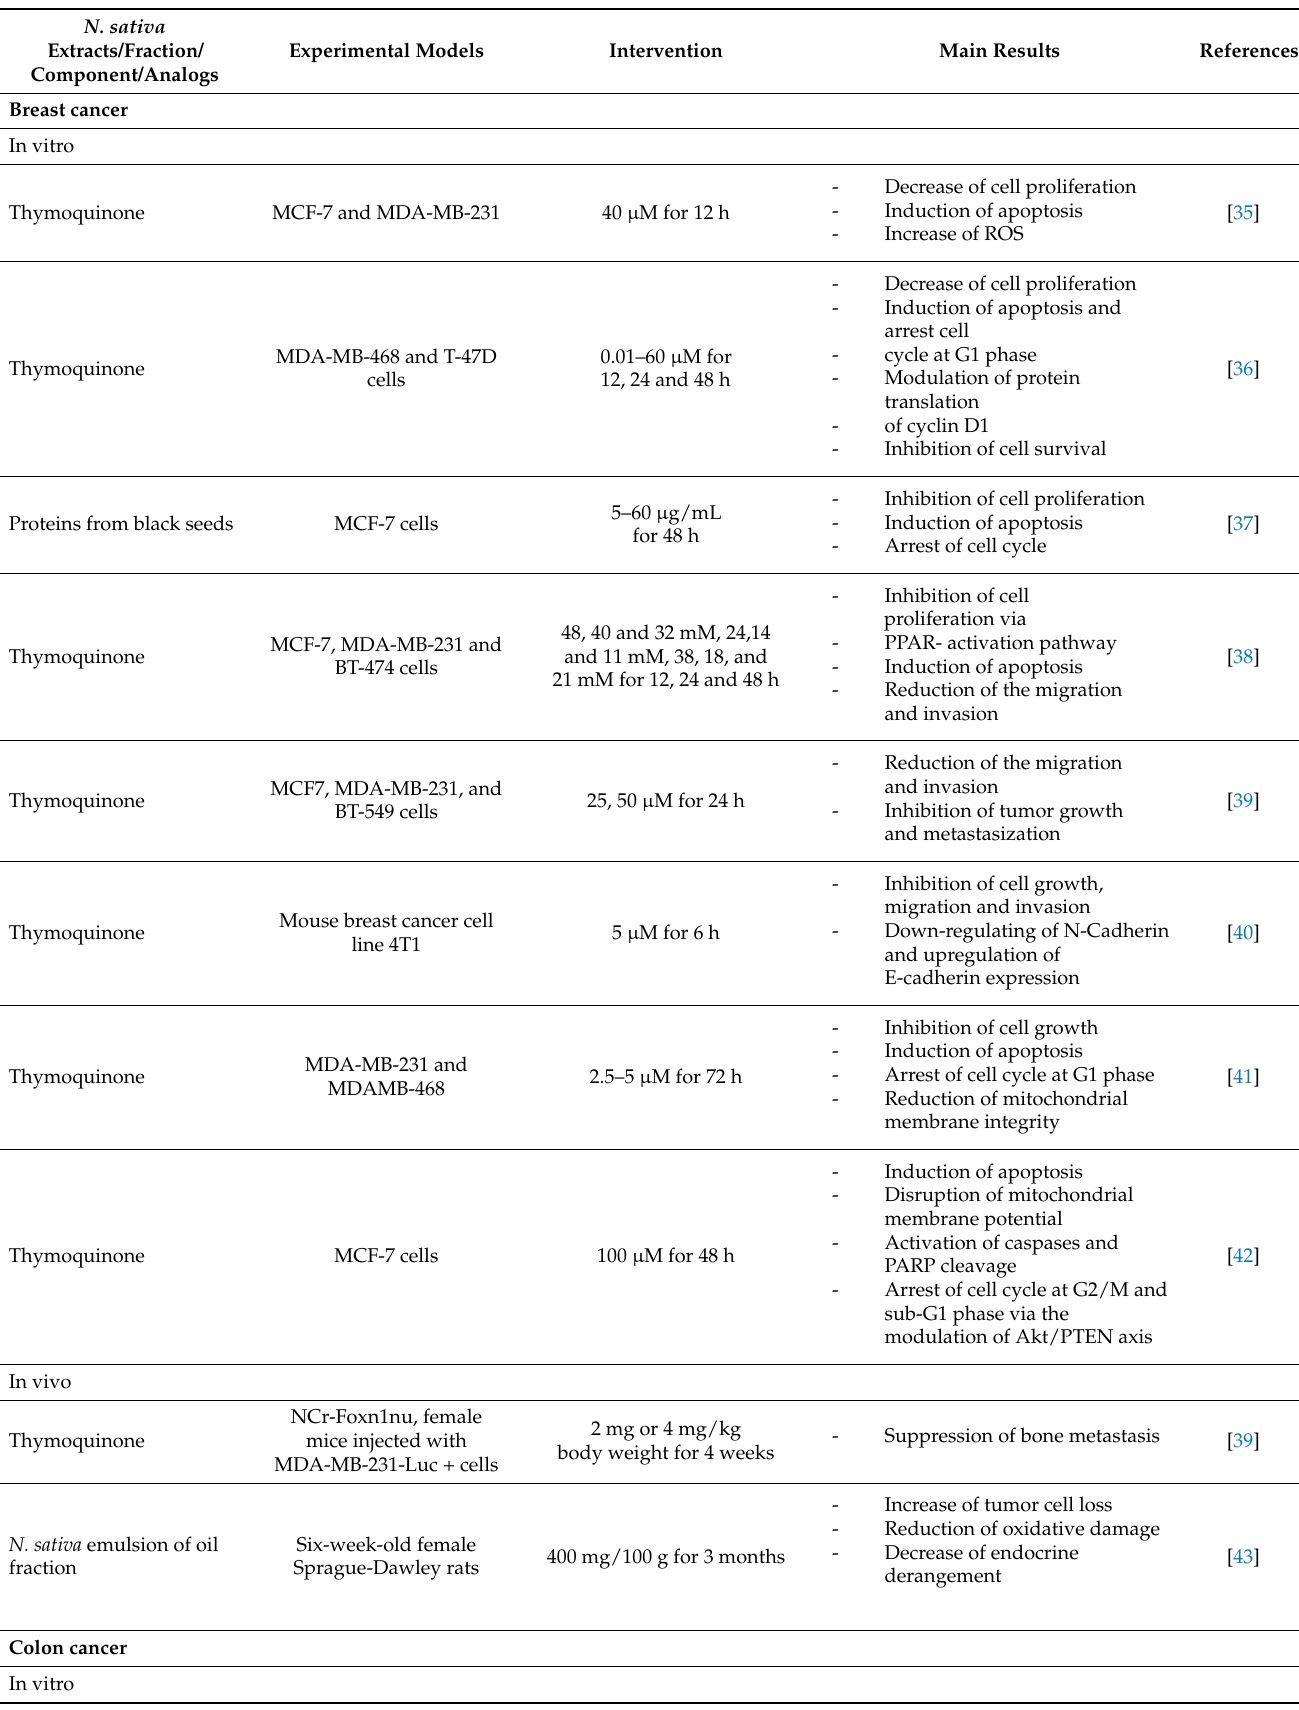
Table 3. Anticancer activities of N. sativa and its main component thymoquinone in different cancer types. N. sativa